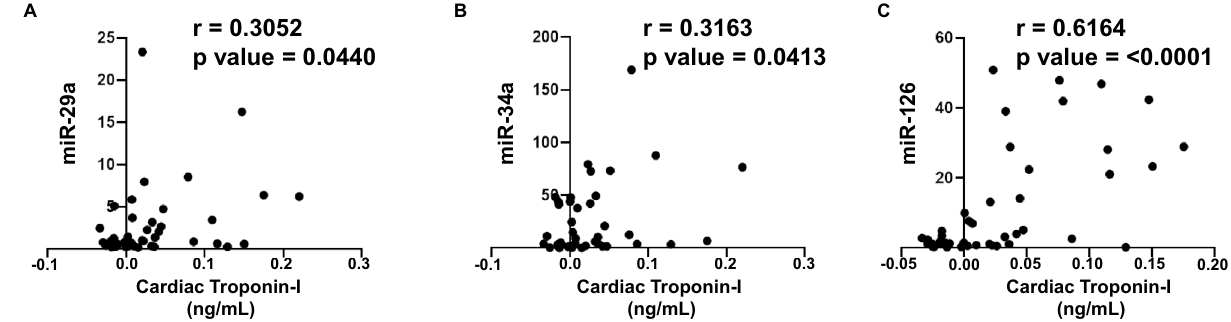
Figure 4. Correlation analysis of circulating miRNAs with high sensitive cardiac troponin I. Correlation was determined using Pearson’s r coefficient using two-tailed p -value to demonstrate significance (alpha = 0.05). Scatter dot plot between cardiac troponin I and circulating miRNAs showing statistical significance, which includes ( A ) miR-29a, ( B ) miR-34a and ( C ) miR-126. Each plot independently shows corresponding correlation coefficient ( r value) and significance ( p value).